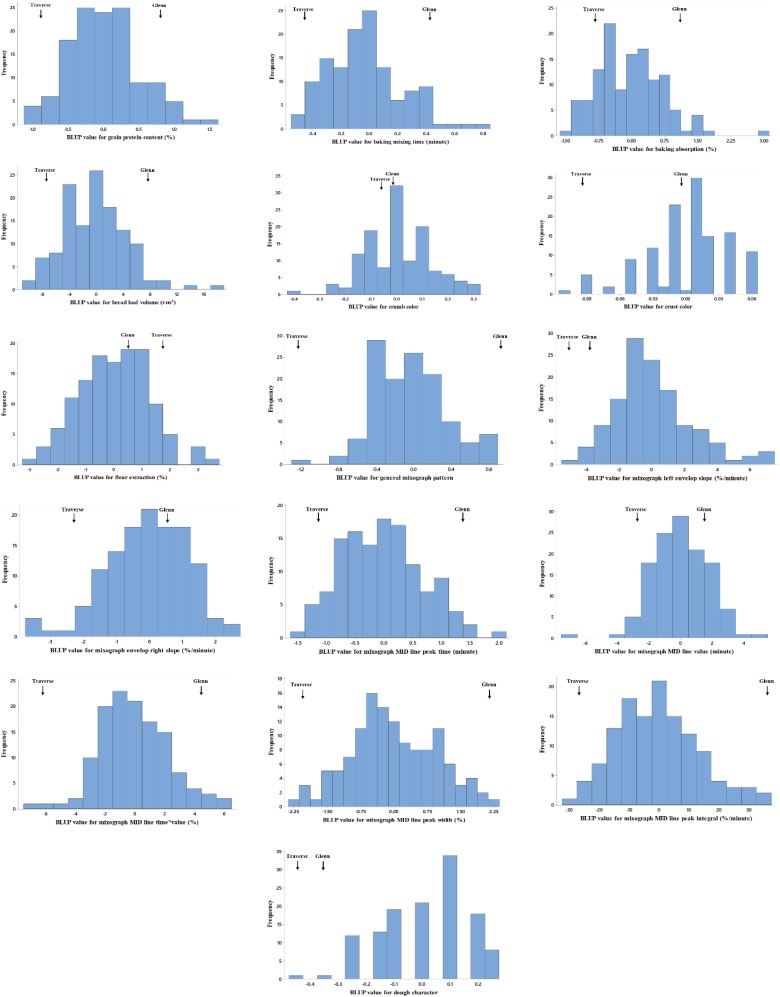
Frequency distribution of BLUP values for end-use quality characteristics of a population of 127 recombinant inbred lines (RILs) derived from a cross between Glenn and Traverse across all environments. Estimates of the parental lines are indicated by arrows.